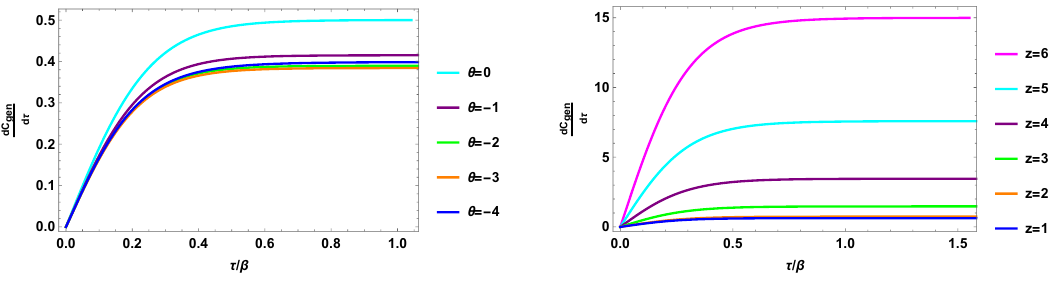
as a function of τ/β for a ( r ) = 1 + λ dτ = 10 − 5 . Right ) d = 2 , θ = 1 and λ 2